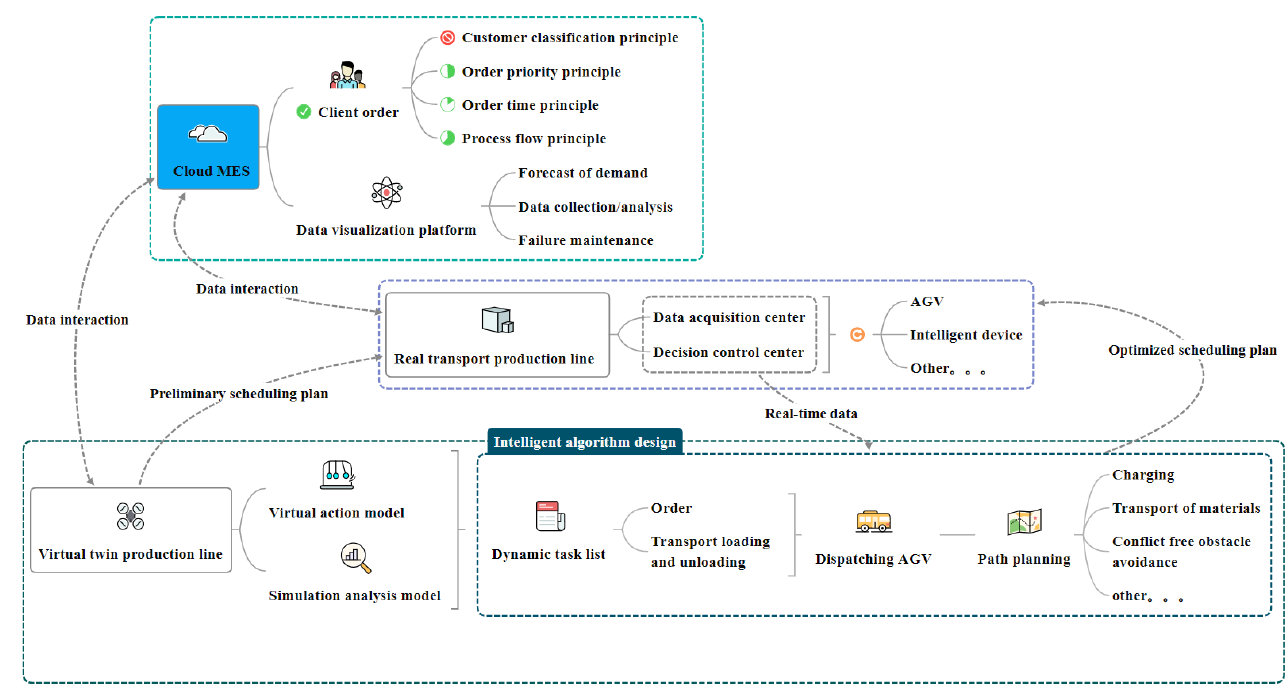
Figure 6. The interaction process of